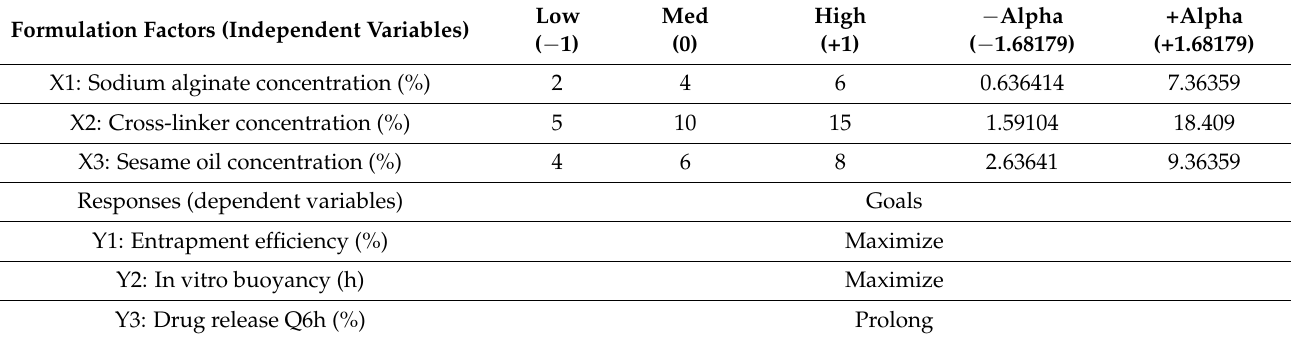
Table 1. The formulation factors and responses based on the central composite design for TEL-loaded oil-entrapped floating alginate